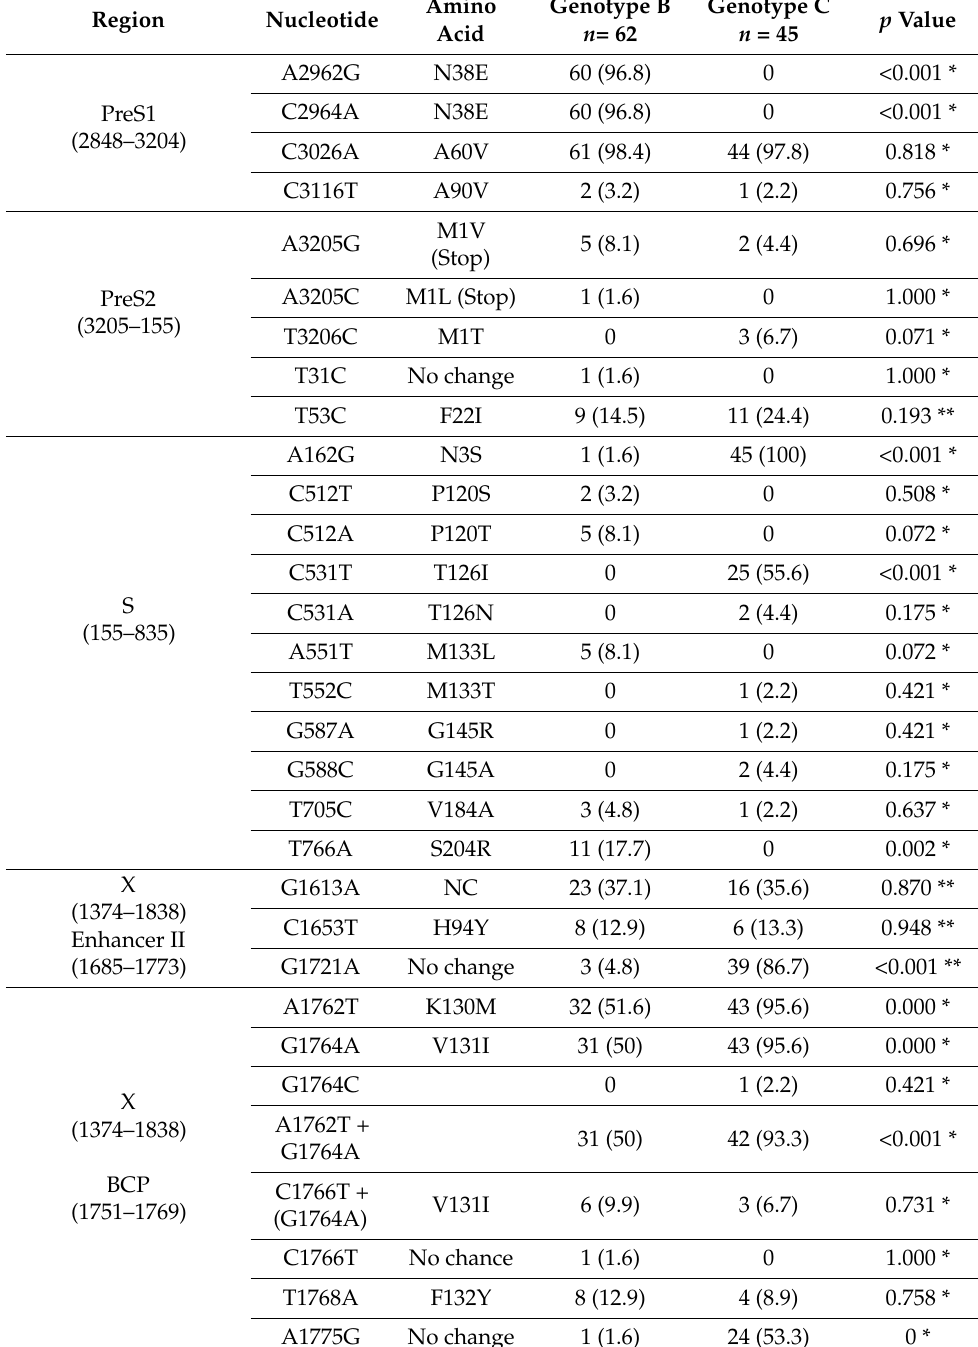
Table 1. Analysis of polymerase gene